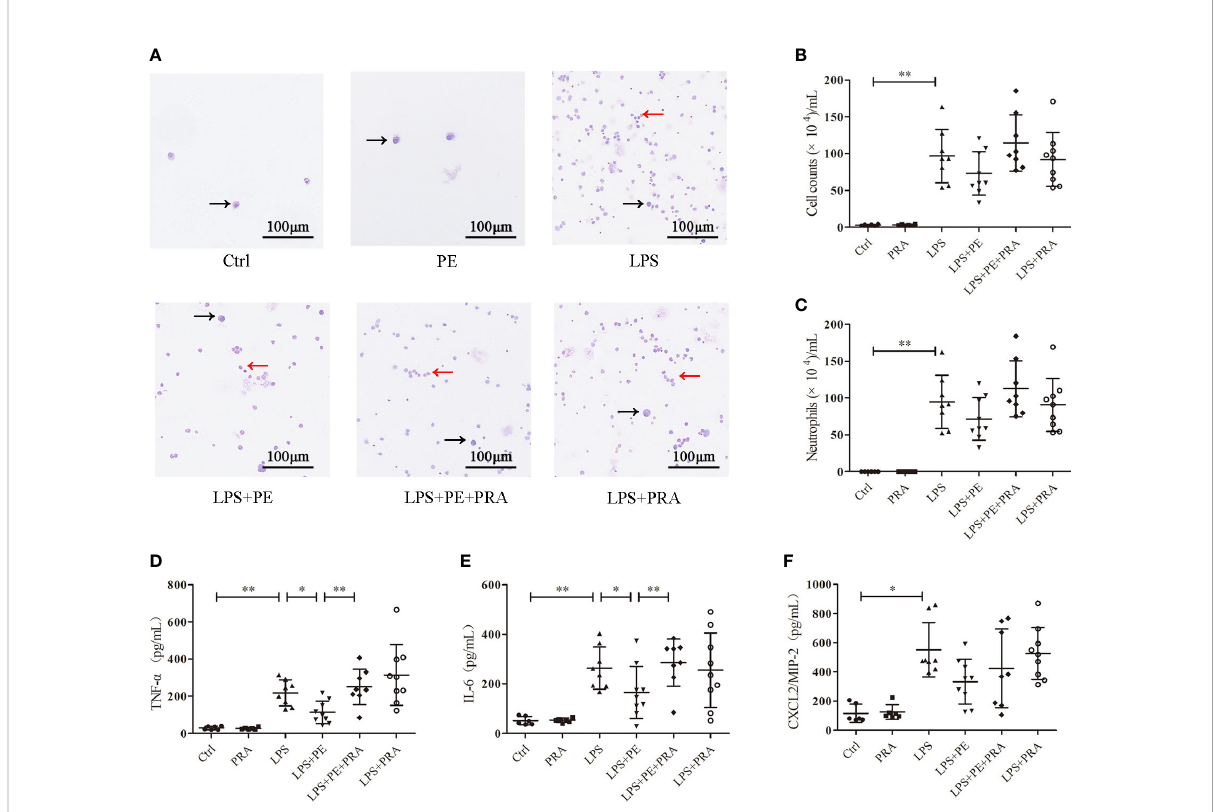
FIGURE 6 Prazosin (PRA) reversed the effect of phenylephrine (PE) on lung in fl ammation in ARDS mice. Mice were given an intratracheal instillation of 2 mg/kg lipopolysaccharide (LPS) to induce ARDS. PRA (10 -5 M) and PE (10 -5 M) were also injected into the trachea 40 min or 20 min before LPS stimulation. Lung tissues and bronchoalveolar lavage fl uid (BALF) were collected 24 h after LPS stimulation. (A) In fl ammatory cells in BALF stained by Wright-Giemsa stain. Scale bar = 100 m M. (B) Counts of total in fl ammatory cells in BALF. (C) Counts of neutrophils in BALF. Levels of TNF- a (D) , IL-6 (E) , and CXCL2/MIP-2 (F) in BALF. Data are represented as the mean ± SD, n = 6 – 10 per group. * p < 0.05, ** p <